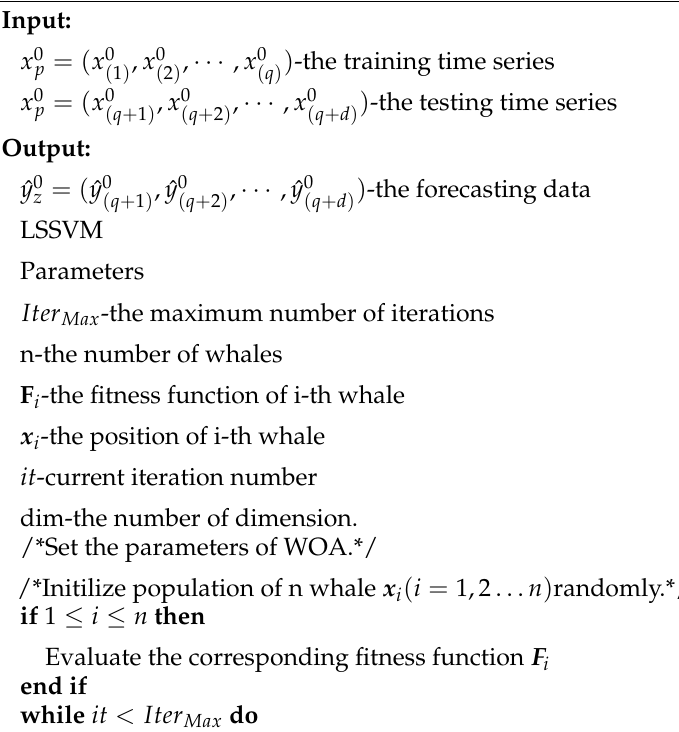
Algorithm 1 WOA-LSSVM: optimize the parameters c and g of LSSVM with